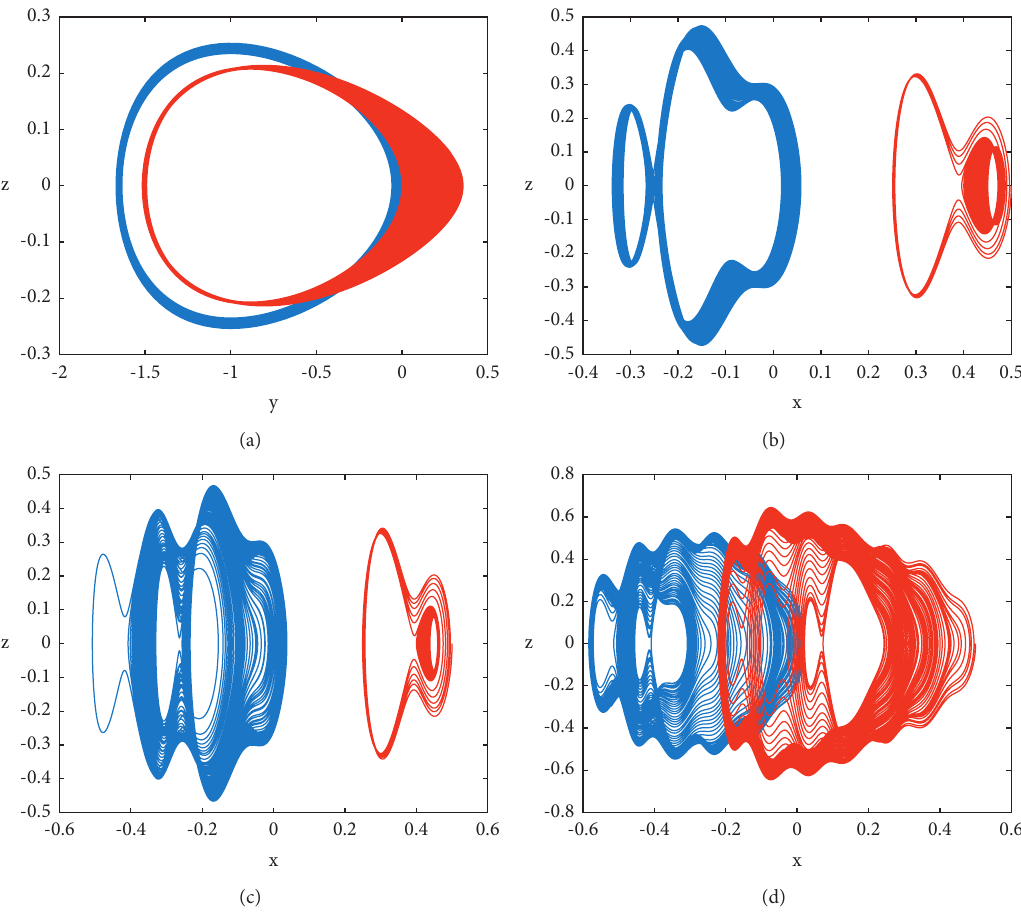
Figure 9: (a) The coexisting periodic attractors in y-z plane. (b) The coexisting periodic attractors in x-z plane. (c) The coexisting chaotic attractor and periodic attractor in x-z plane. (d) The coexisting chaotic attractors in x-z